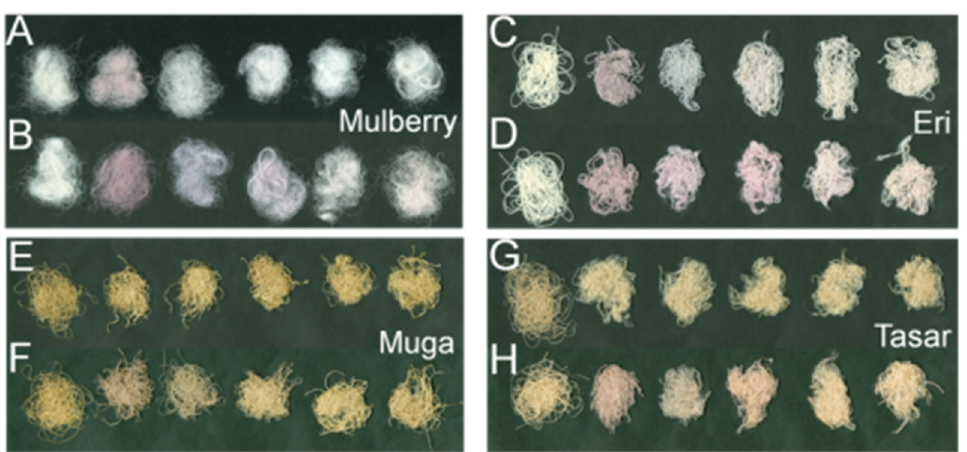
Figure 3. Photographs of the various silks after Gold NPs impregnation. Mulberry: scCO 2 ( A ), control ( B ); Eri: scCO 2 ( C ), control ( D ); Muga: scCO 2 ( E ), control ( F ); and Tasar: scCO 2 ( G ), control ( H ). The first fiber bundle from the left was the native untreated silk in all photographs. Then the fibers were treated with five different sizes of gold nanoparticles (5, 20, 50, 100, and 150 nm), respectively. The color change correlates with the initial gold solutions’ color.